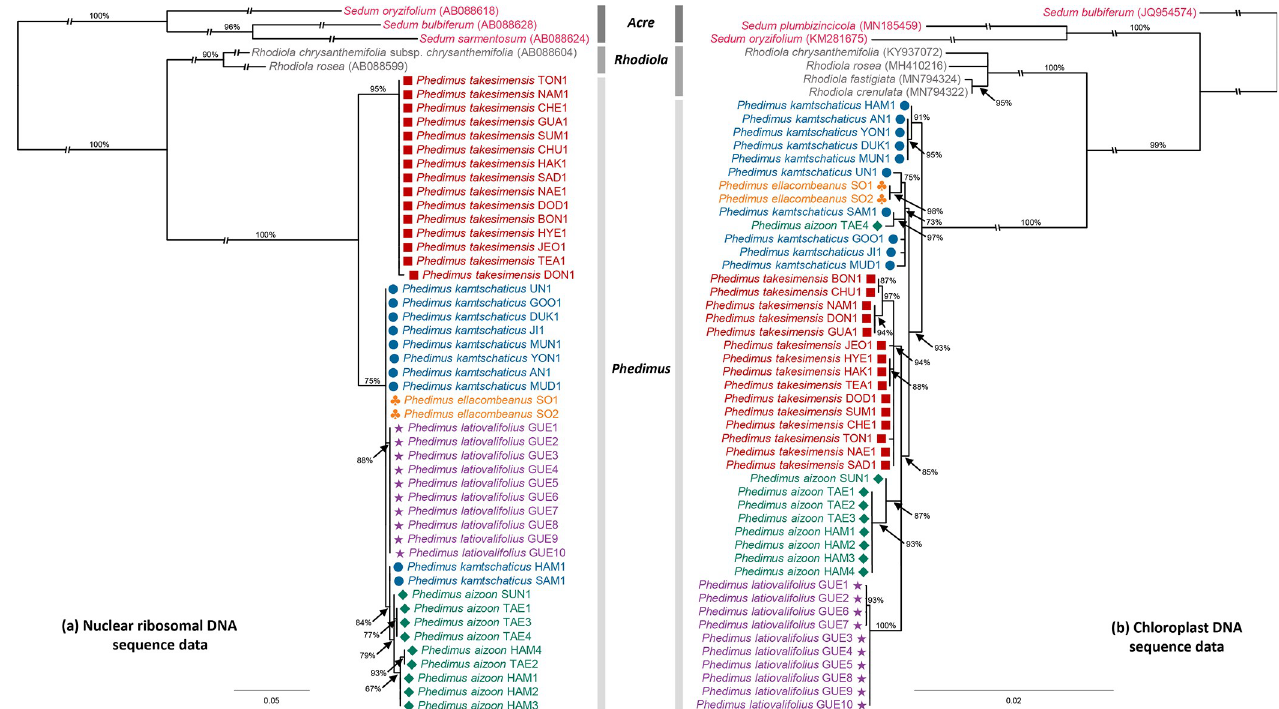
Fig 3. Maximum likelihood tree based on (a) nuclear ribosomal DNA internal transcribed spacer regions and (b) four chloroplast noncoding sequences. Bootstrap support values are shown at each node.